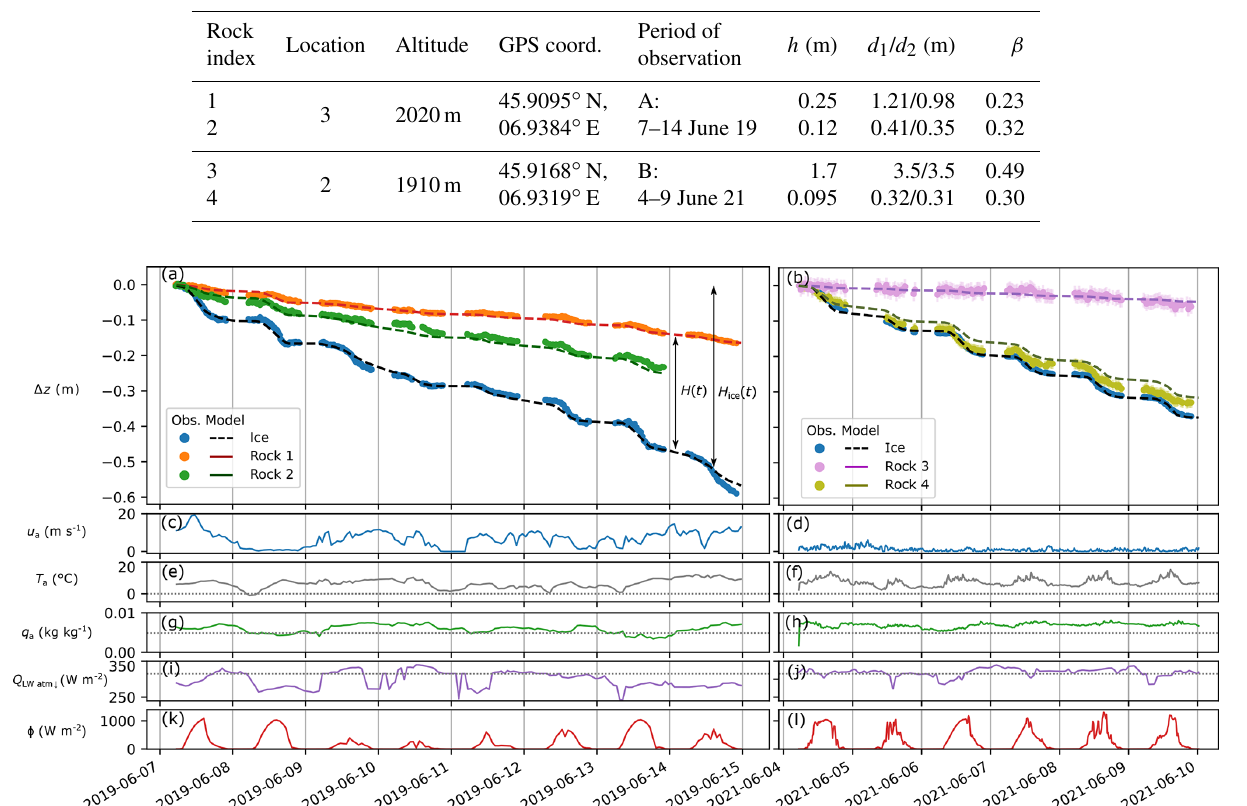
Table 1. Characteristics of the rocks studied.